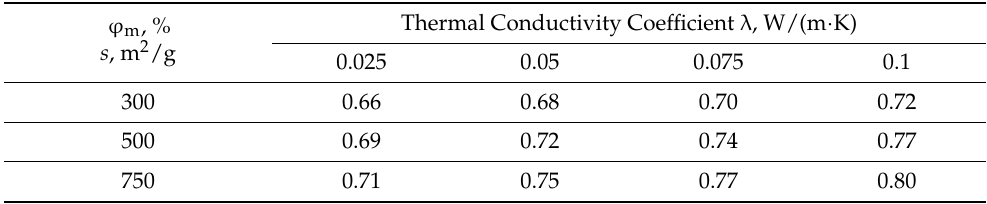
Table 2. Thermal conductivity coefficient of nanofluids with flat nanoparticles depending on their specific surface area at various mass concentrations of nanoparticles in the base fluid ( ϕ m )